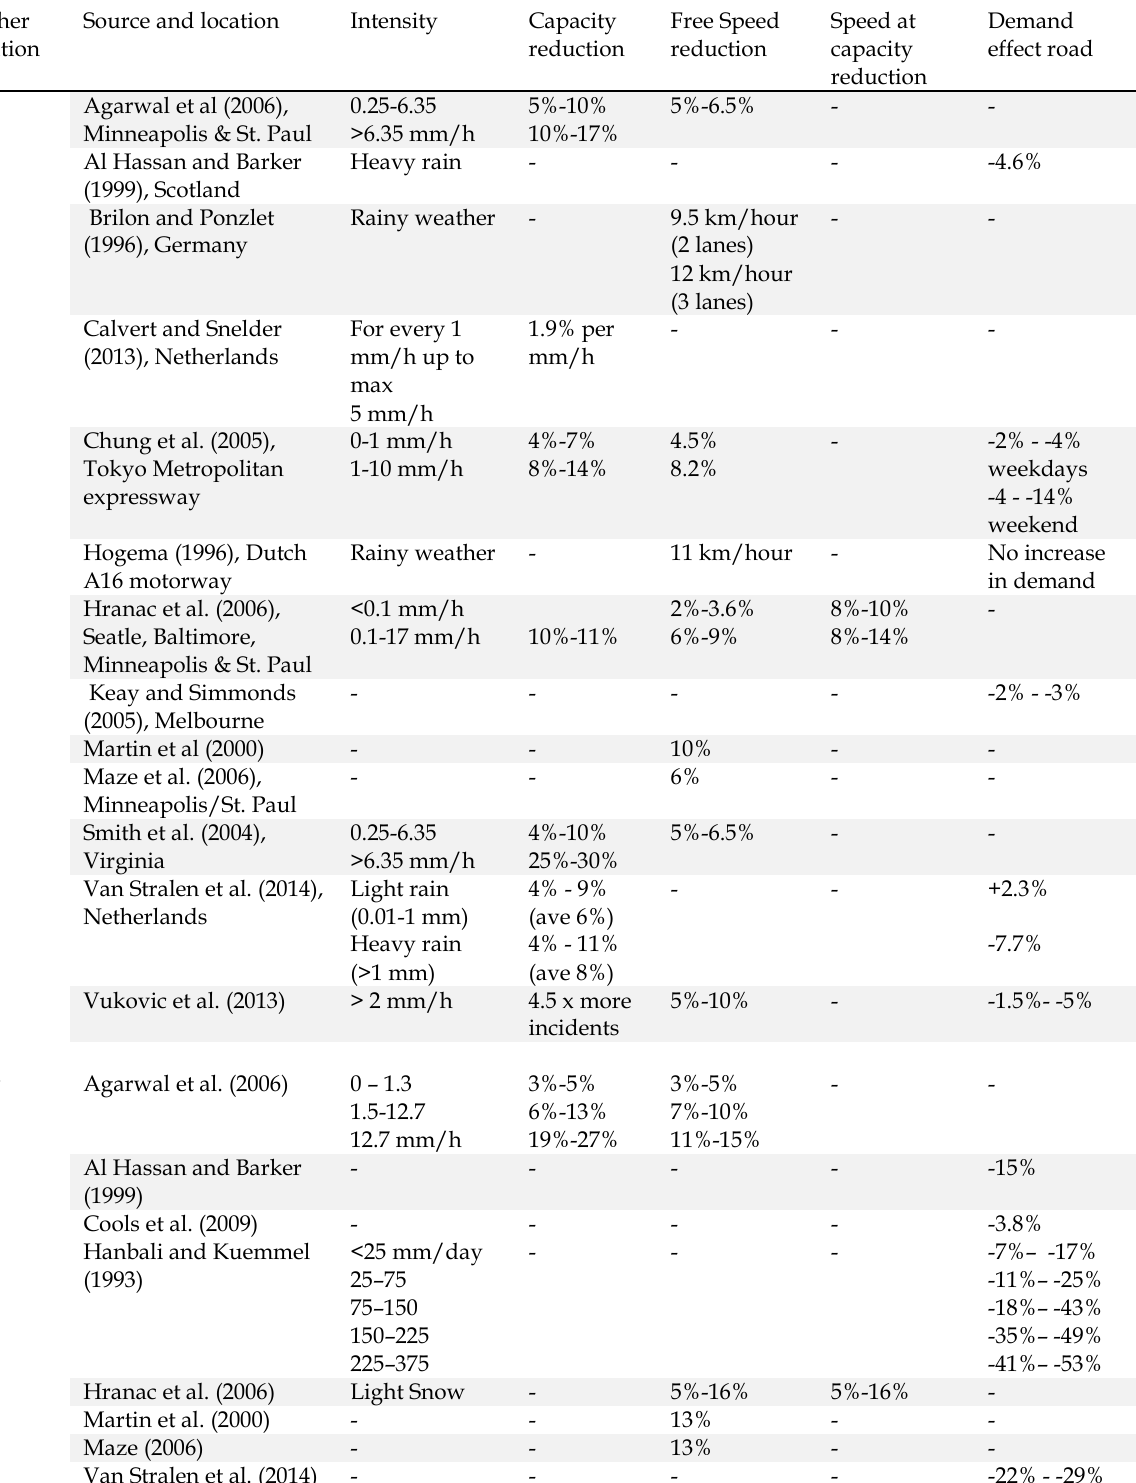
Table 1. Expected road supply and demand effect of adverse weather